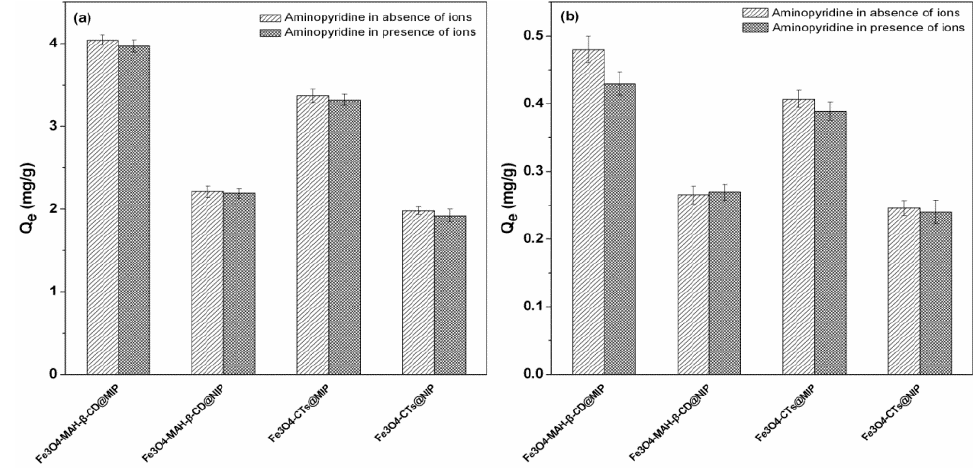
Figure 12. Influence of coexisting ions on the aminopyridine binding onto Fe 3 O 4 -CTs@MIP, Fe 3 O 4 -MAH- β -CD@MIP and MNIPs. ( a ) C 0,aminopyridine : 0.01 mg · mL − 1 ; ( b ) C 0,aminopyridine : 0.001 mg · mL − 1 , C Na + : 1.149 mg · mL − 1 , C K + : 0.039 mg · mL − 1 , C Mg 2+ : 0.122 mg · mL − 1 , C Ca 2+ : 0.04 mg · mL − 1 , C Cl − : 1.882 mg · mL − 1 , C SO4 2 − : 0.48 mg · mL − 1